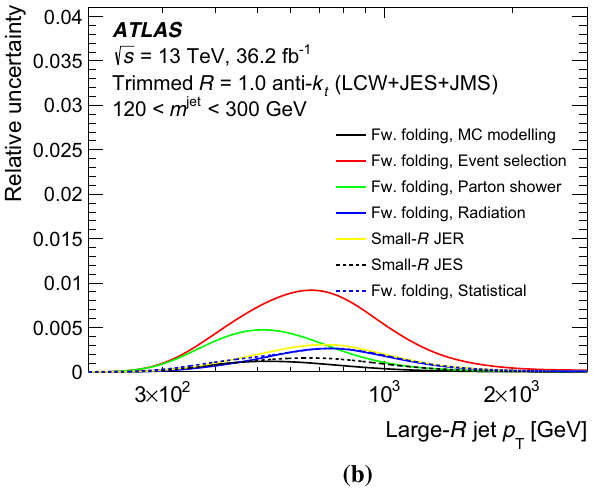
Fig. 32 BreakdownofthecombinedJMSuncertaintyshowninFig.30 as a function of jet transverse momentum p T for the jet mass bin 120– 300 GeV. Contributions are shown for each of the nuisance parameters of the a R trk and b forward-folding methods. The vertical axis reflects